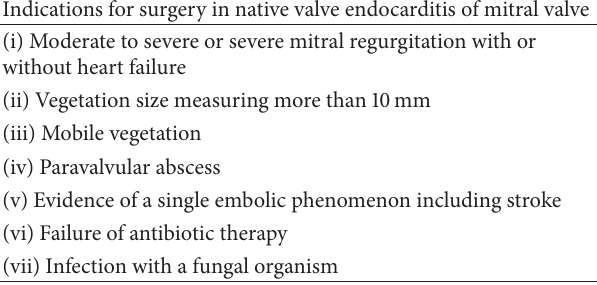
Table 3: Indication of surgical management of Mitral valve IE. Indications for surgery in native valve endocarditis of mitral